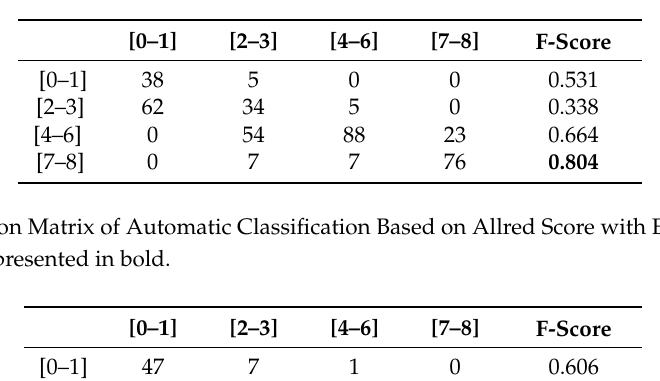
Table 1. Confusion Matrix of Automatic Classification Based on Allred Score with Expert-1. The best F-score value is presented in bold.